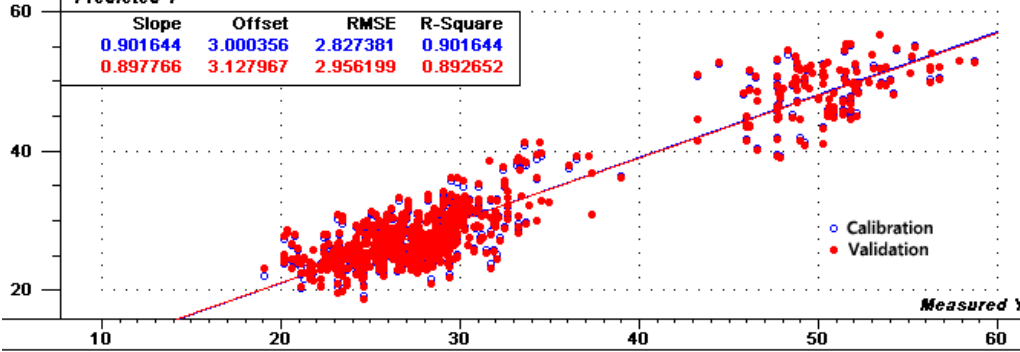
Figure 4. Scatter plots analytically determine and predict values for PLS1 models by Harmonization differential mathe- matical treatments.